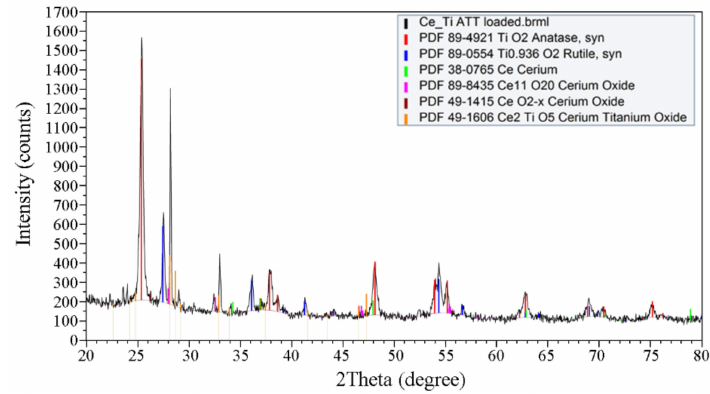
Figure 4. XRD pattern of Ce x Ti y O z nanocontainers loaded with ATT.